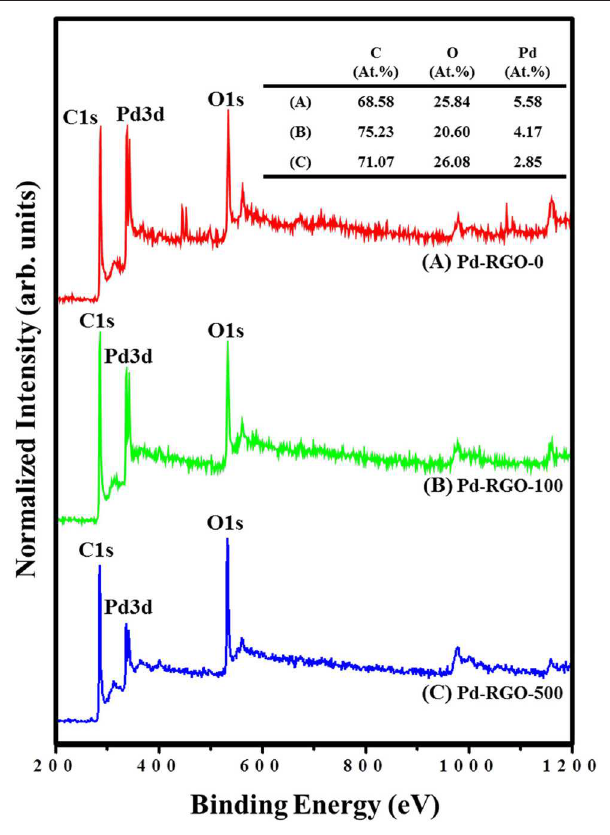
FIGURE 7 | Raman spectra of (A) Pd-RGO-0, (B) Pd-RGO-100, and (C) Pd-RGO-500. Inset shows I G /I D ratio for different